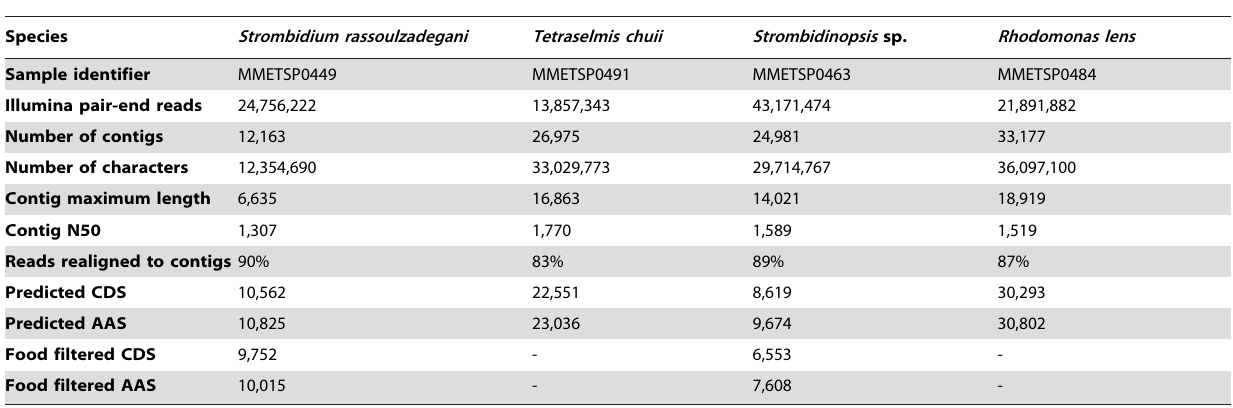
Table 1. Transcriptome